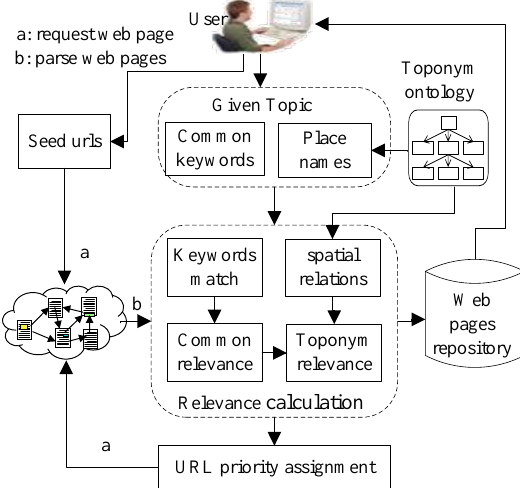
Figure 2. Workflow of focused crawling based on place names and spatial relations